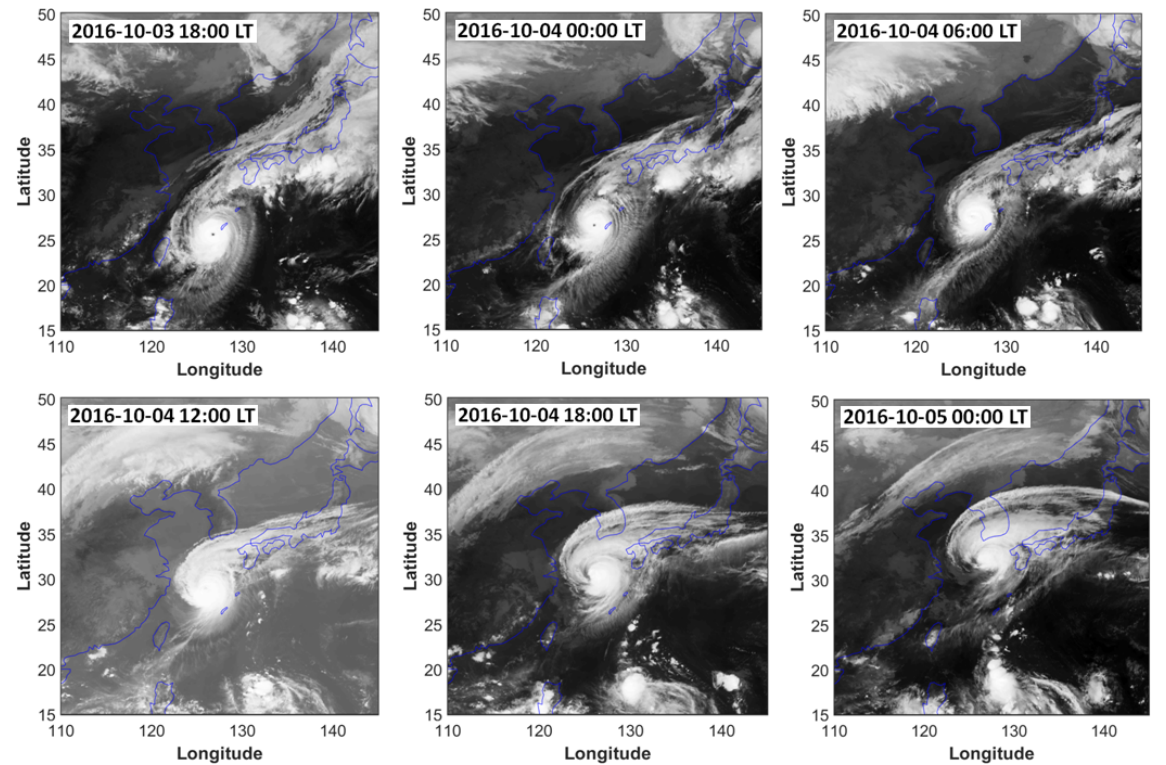
Figure 3. Consecutive satellite images of Typhoon Chaba from MTSAT-1R. The period is from 18:00LT on 3 October to 00:00LT on 5 October 2016, with an interval of